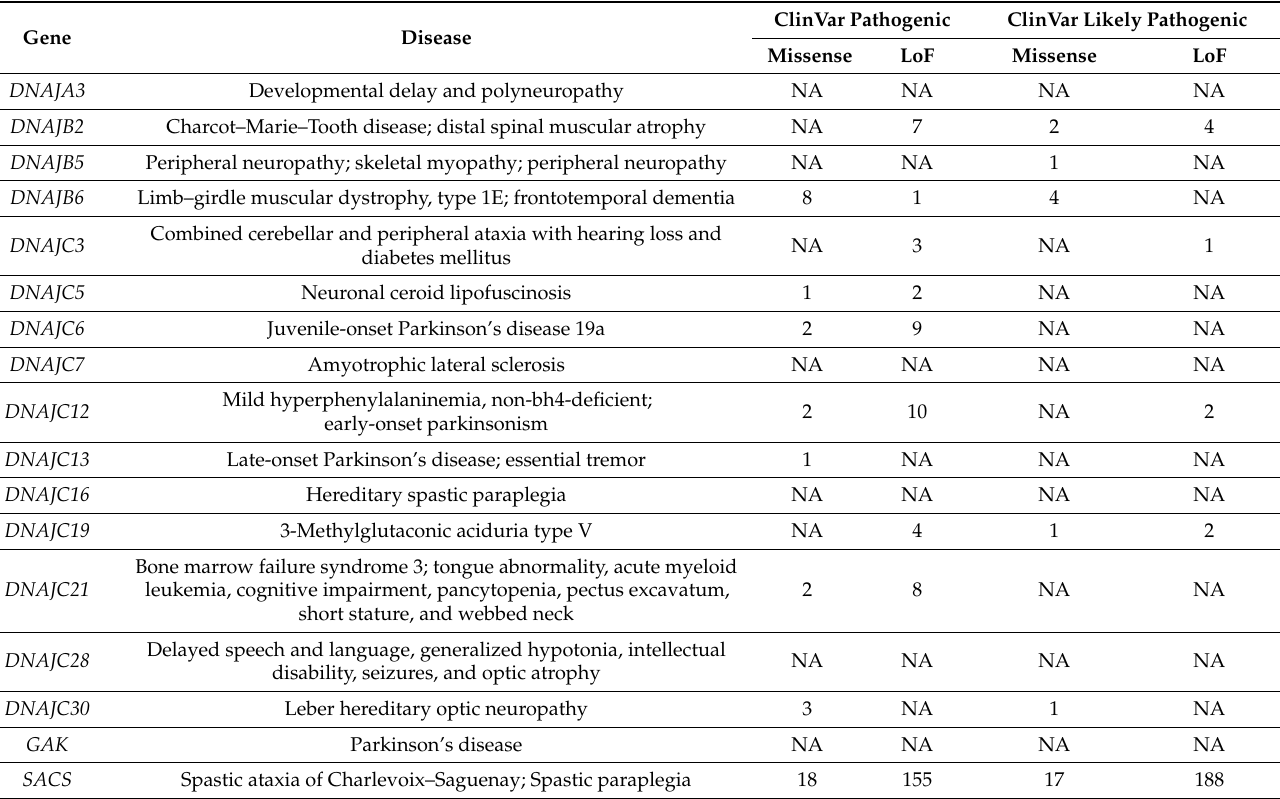
Table 1. Number of variants in J proteins, otherwise referred to as Hsp40s, previously associated with neurological phenotypes and/or phenotypes presenting with neurological